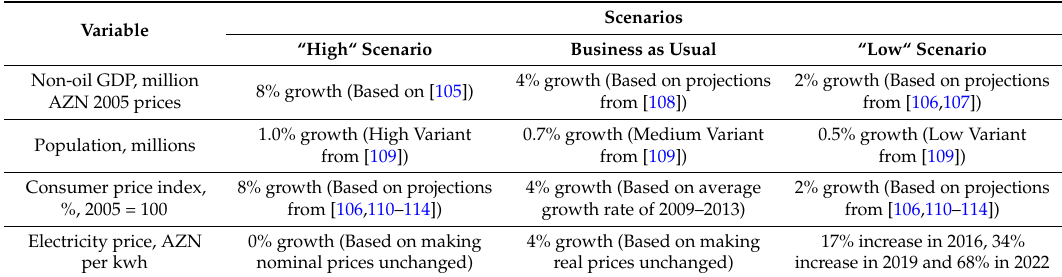
Table 8. Assumptions on the Variables across Scenarios,